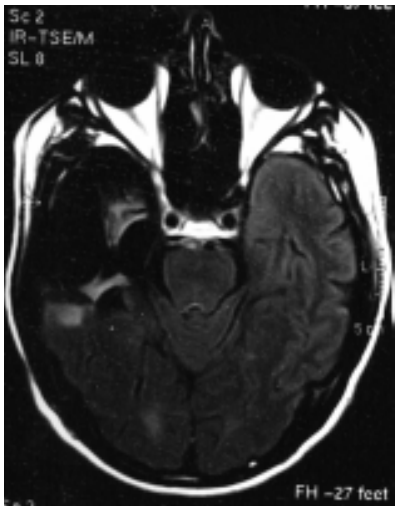
Fig.2. Axial T1weighted MRIscan reveals encephalomalacic region in the temporal lobe and total resolution of the